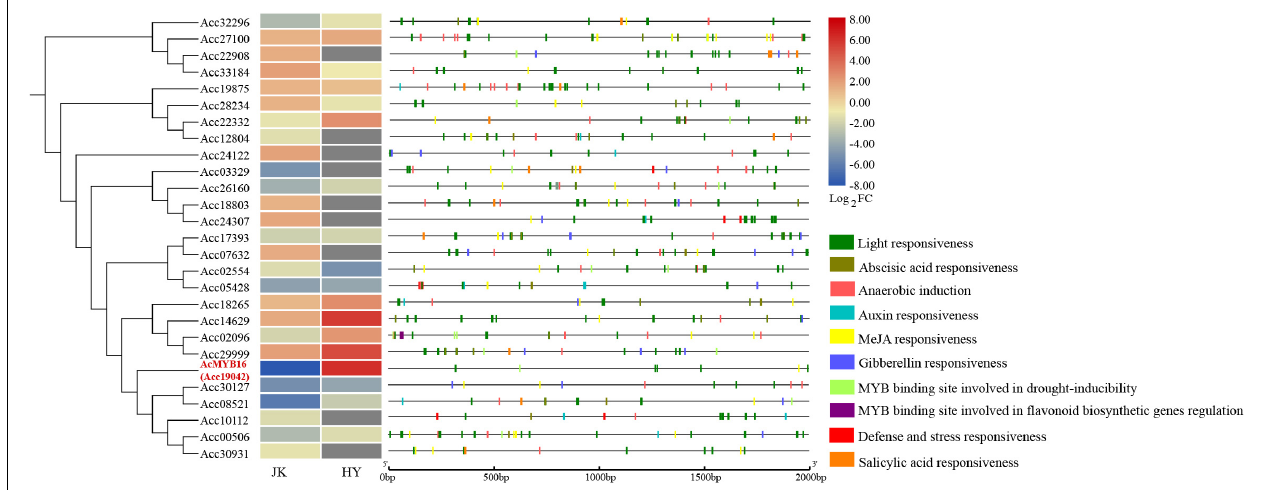
FIGURE 5 | Distribution of cis -acting regulatory elements (CREs) involved in the responsiveness of the promoters of 27 candidate R2R3-MYBs.